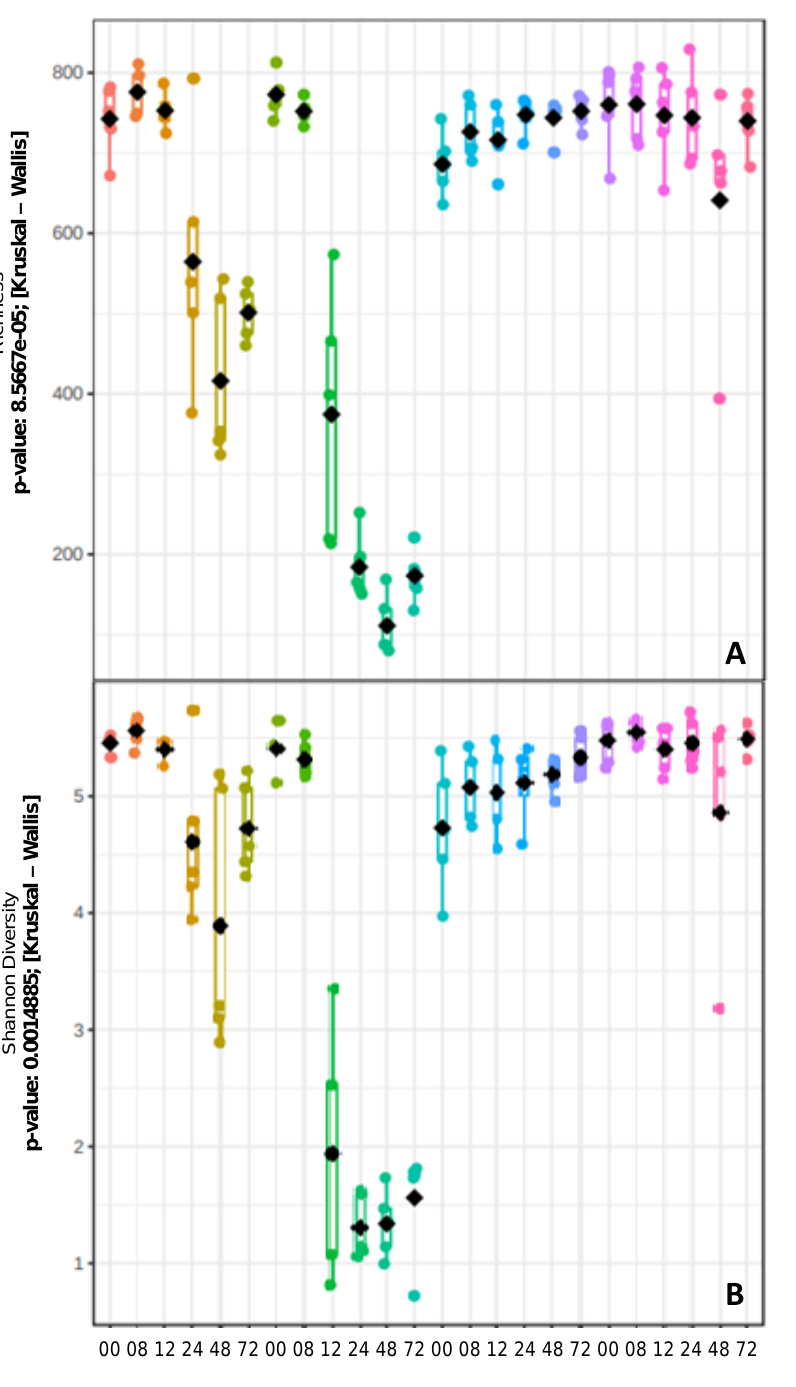
Figure 1. Richness and diversity of bacterial communities predominant in fecal samples 72 h following treatments: water–saline—WS; water–buffer—WB; starch–saline—SS; starch–buffer—SB. T0—before gastric administration of water or starch; T8—08 h; T12—12 h; T24—24 h; T48—48 h; T72—72 h. ( A ) richness (number of species observed); ( B ) diversity by Shannon